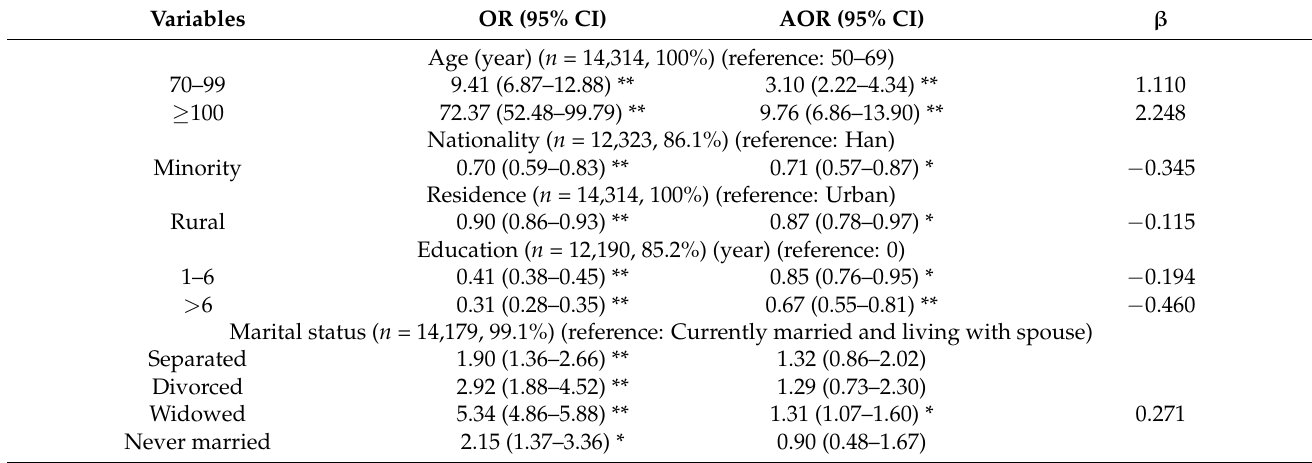
Table 2. Univariate and multivariate logistic regressions of the influencing factors for